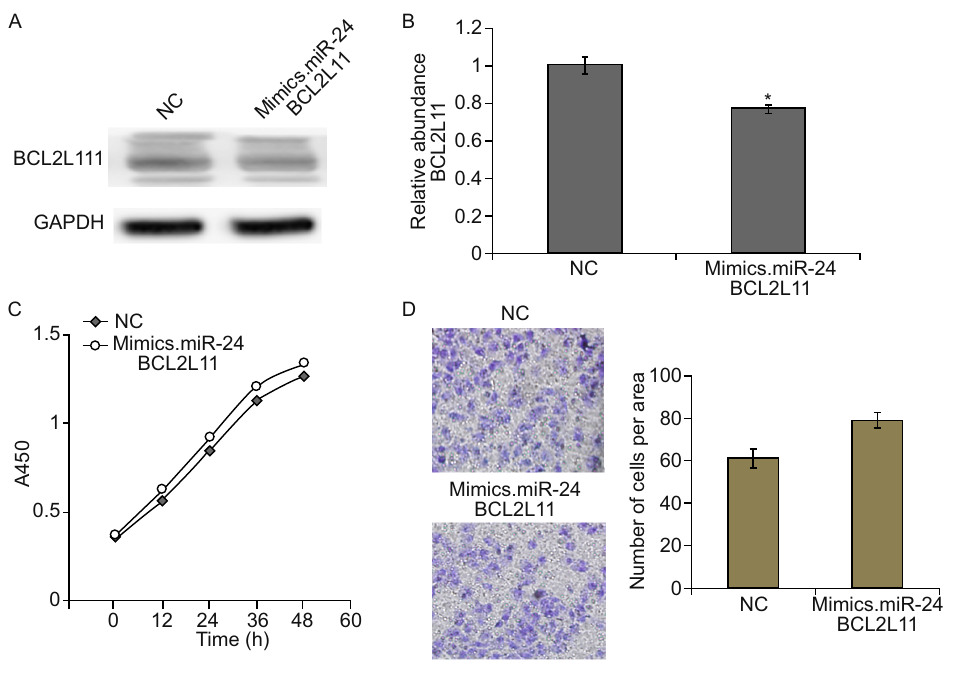
Figure 4. BCL2L11 rescues miR-24-induced cell growth and migration. SGC7901 cells were co-transfected with miR-24 mimics and BCL2L11 lenti-virus plasmid. The protein levels were detected by Western blot, and cell growth and migration were determined by CCK8 and Transwell assays respectively. (A) Western blot analysis of BCL2L11 expression in SGC7901 cells co-overexpressed with miR-24 and BCL2L11. (B) Quantitative analysis of (A). (C and D). Cell proliferation (C) and migration (D) of SGC7901 cells treated with miR-24 mimics and BCL2L11 lenti-virus simultaneously. ** indicates P <